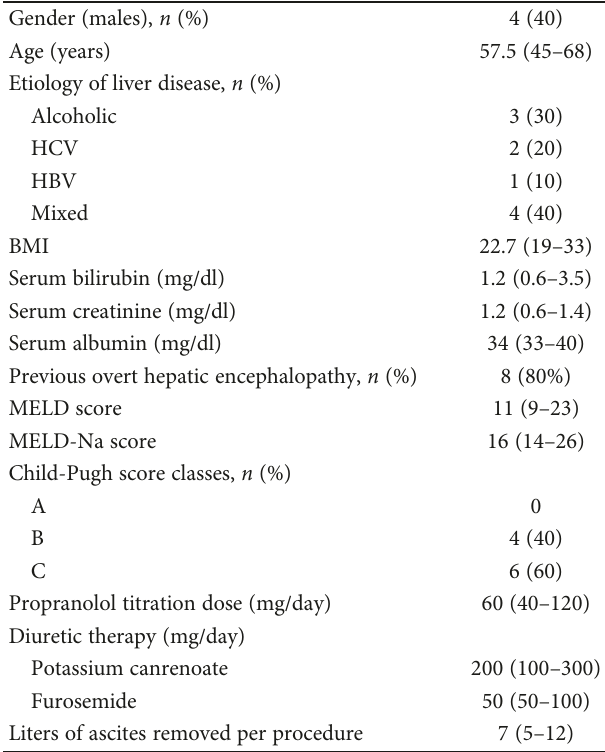
Table 1: Characteristics of enrolled patients. Continuous variables are expressed as median (range). BMI: body mass